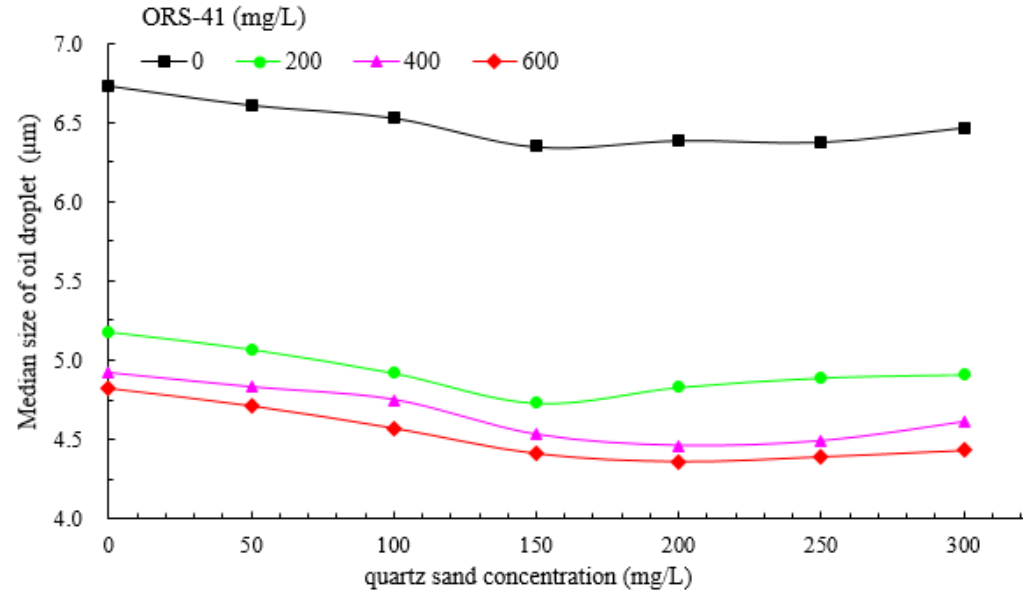
Figure 13. The synergetic effect of the quartz sand particles and surfactant on the oil droplet size (polymer concentration 500 mg/L, alkali concentration 600 mg/L).